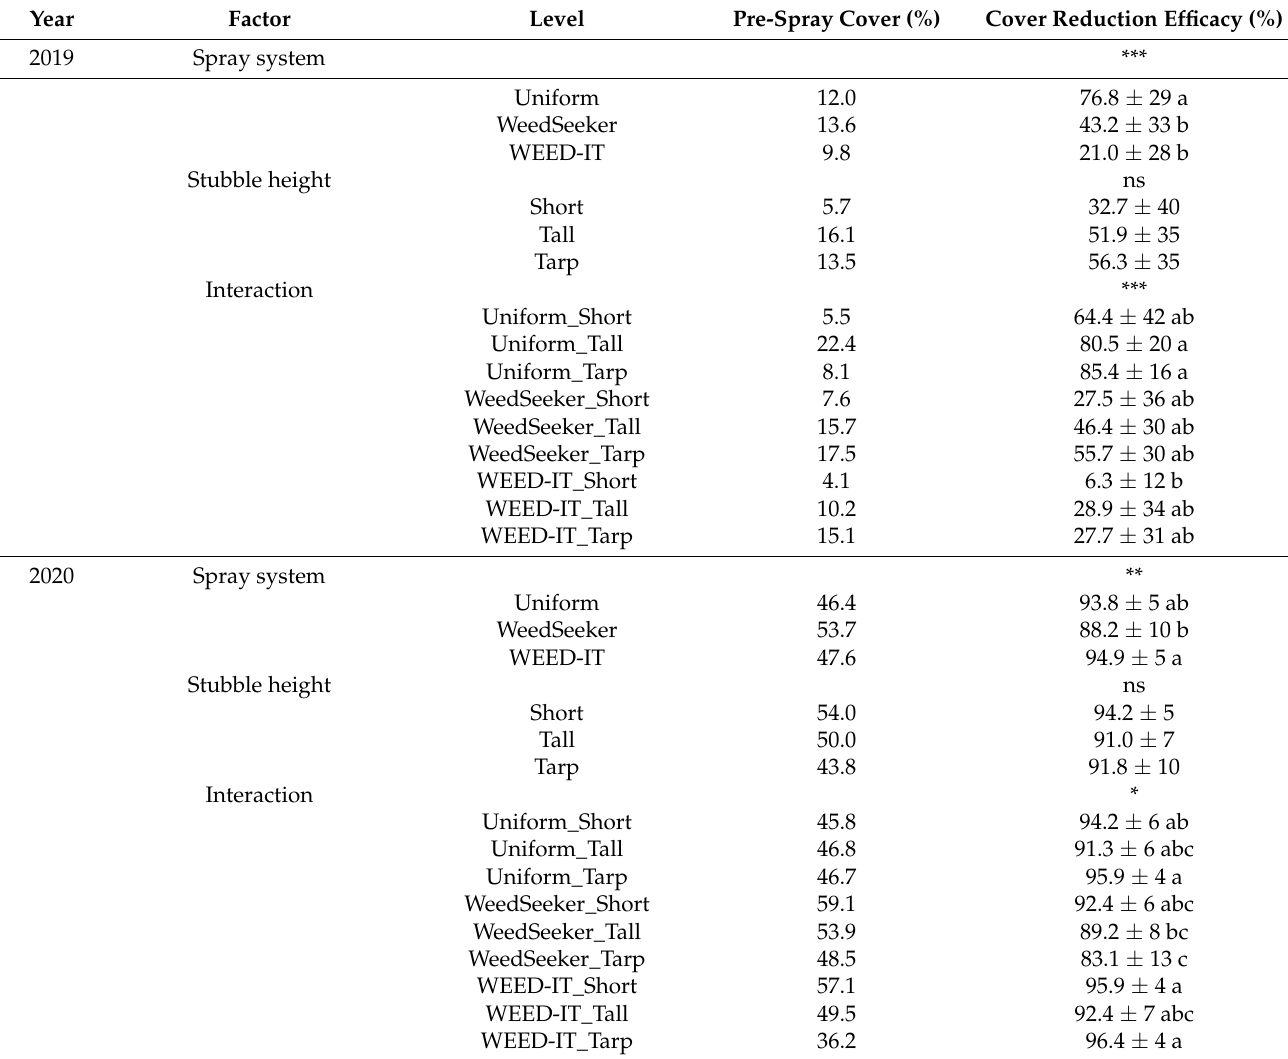
Table 4. Pre-spray weed cover and herbicide control efficacy (mean ± SD) for plant cover in the residue trial during 2019 and